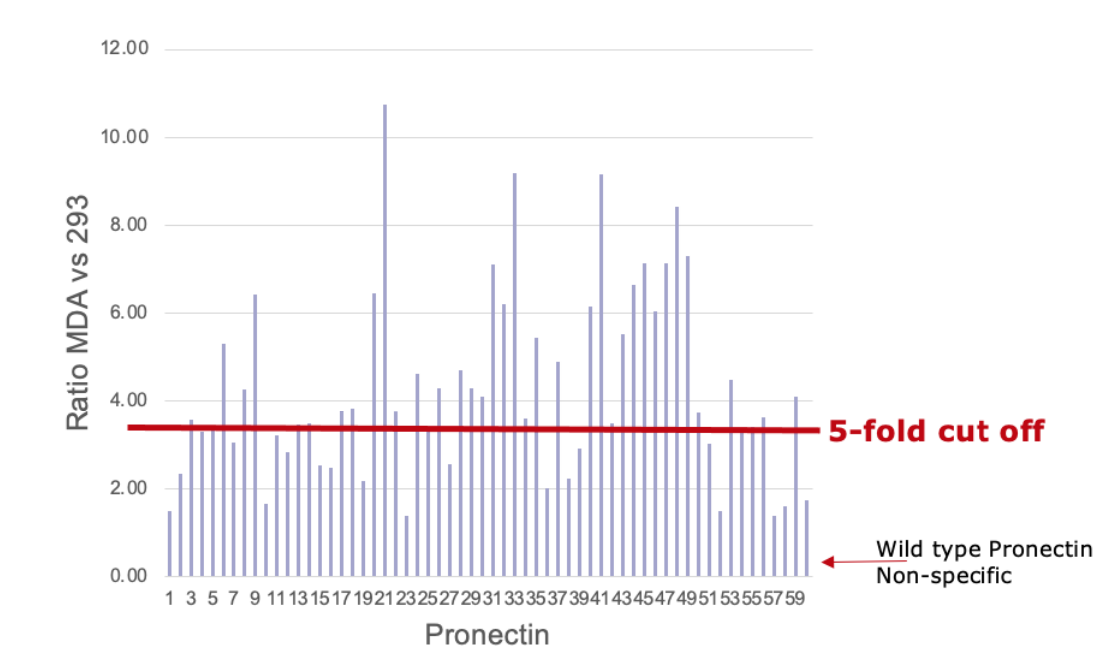
Figure 6. ( A ) Shows the shift in the fluorescence intensity on the population of seven AXL positive cell-lines using an anti-AXL-APC conjugated antibody. MDA-MB-231 has the most AXL expression. ( B ) Show that HEK-293 cells have no AXL expression and that the AXL antibody was specific to the AXL receptor on MDA-MB-231 cells. ( C ) All 59 AXL Pronectins were analyzed by flow cytometry on 293 cells and MDA-MB-231 cells. The ratio of the MFI on MDA-MB-231 cells vs. 293 cells is graphed. The last bar is the binding of soluble wild-type 14FN3 protein and show the non-specific binding levels of the assay. The Pronectins above the 5.0 ratio for AXL binding are the lead candi- dates.